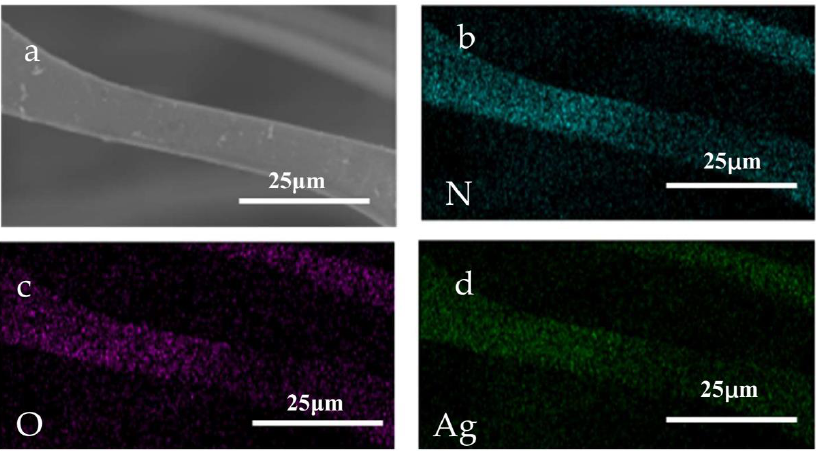
Figure 4. The energy-dispersive spectroscopy (EDS) map of the MS–TA–Ag ( a – d ).